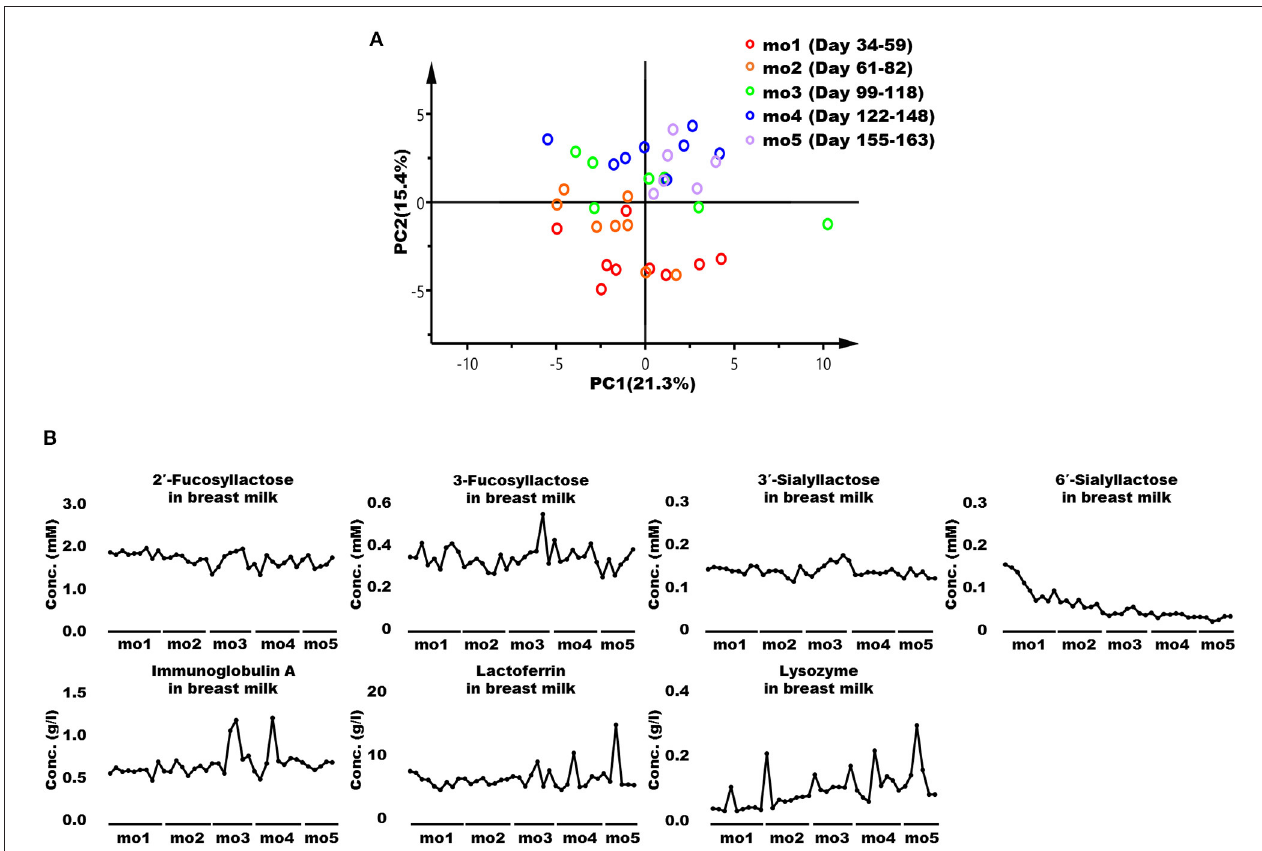
FIGURE 2 | Principal component analysis (PCA) and changes in the bioactive components of breast milk. (A) PCA score plots derived from components such as low-molecular-weight metabolites, major nutrients, and antibacterial proteins in breast milk collected at months 1–5 postpartum. Each symbol represents an individual breast milk sample. (B) Changes in levels in the human milk oligosaccharides (HMOs) immunoglobulin A (IgA), lactoferrin (LF), and lysozyme (LYZ) in breast milk. mo,